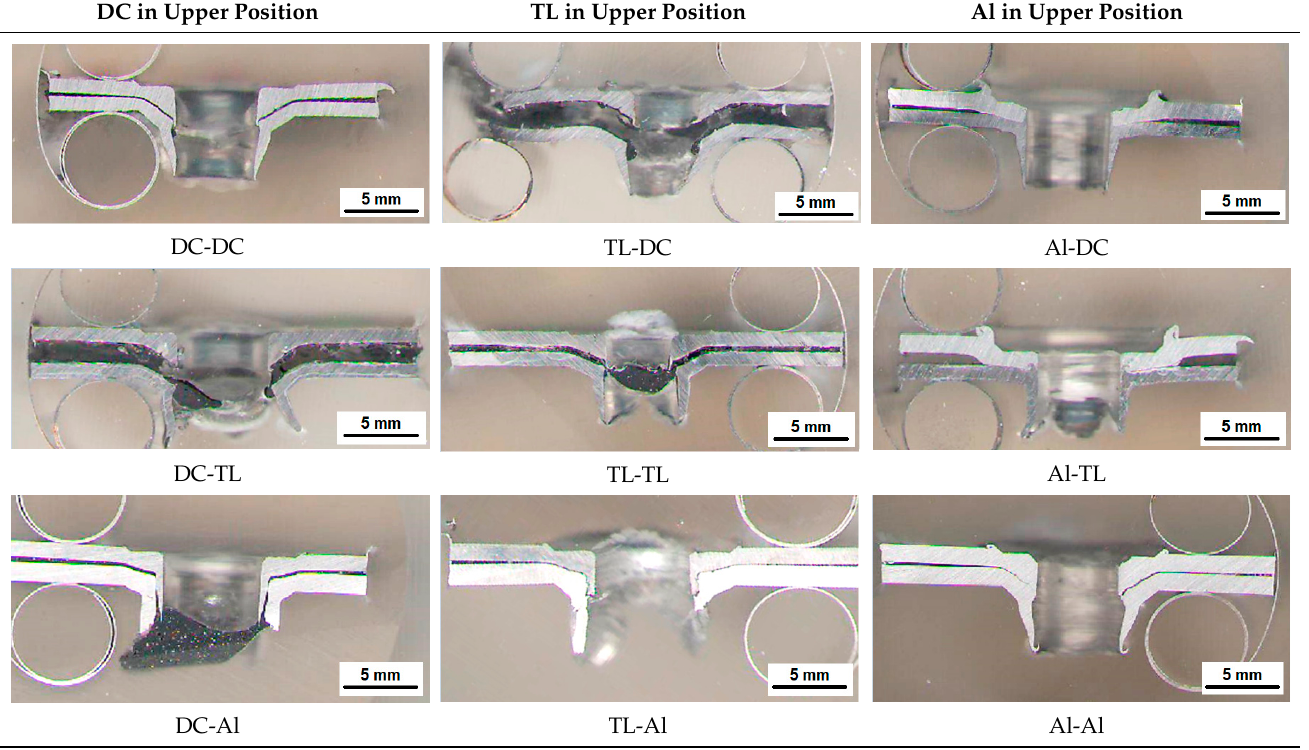
Table 8. Macroscopic sections of individual combined joints.